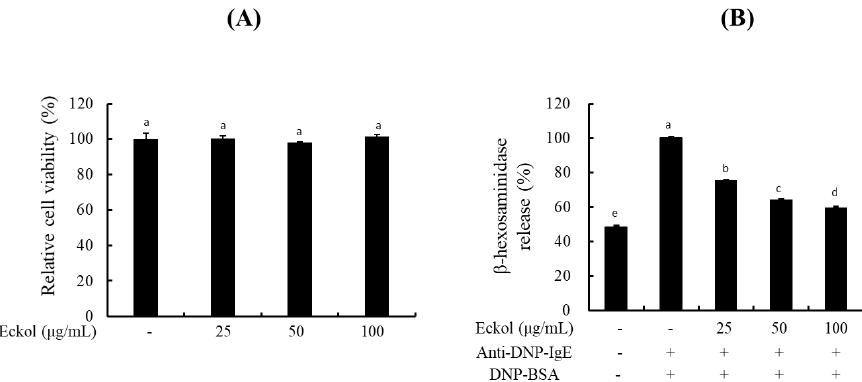
Figure 2. E ff ect of eckol on β -hexosaminidase release in IgE / BSA-stimulated BMCMC. ( A ) Cytotoxicity Figure 2. Effect of eckol on  -hexosaminidase release in IgE/BSA-stimulated BMCMC. ( A ) of eckol in BMCMC ( B ) β -hexosaminidase content in IgE / BSA-stimulated BMCMC. Data are Cytotoxicity of eckol in BMCMC ( B )  -hexosaminidase content in IgE/BSA-stimulated BMCMC. Data